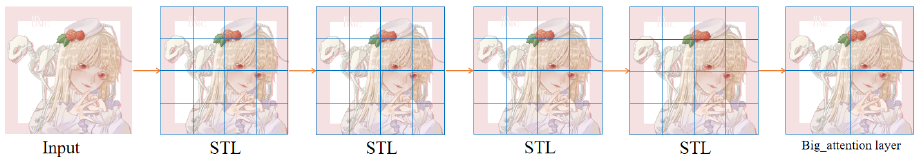
Figure 13. Self-attention window changes in a deep feature extraction network. In the beginning, we divide the image into several small windows. In the last stage, we divide the image into four